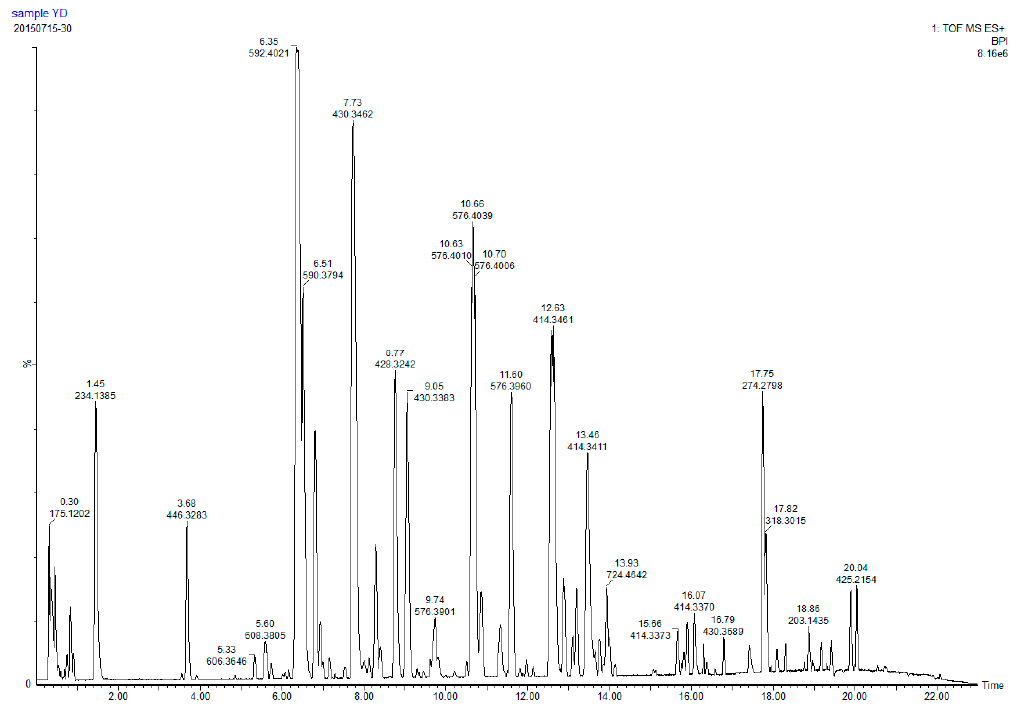
Figure 1. Base peak chromatogram of Fritillaria ingredients.